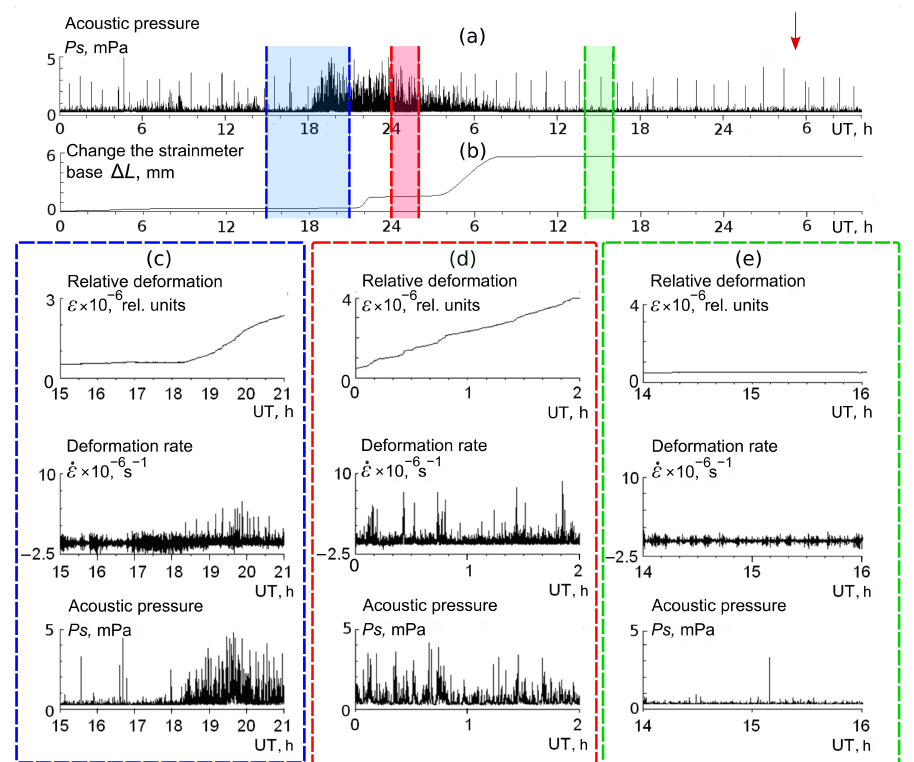
Figure 6. Record fragment of acoustic emission in different ranges and rock deformations from 00:00 on 6 October 2009, to 10:00 on 8 October 2009. ( a ) Variations of acoustic pressure P s , accumulated over 4 s in the frequency range 2.0–6.5 kHz, ( b ) change in the strainmeter base ∆ L . The red arrow shows the earthquake moment. At the bottom ( c – e ), enlarged fragments of the rock relative deformation ε , the deformation rate ˙ ε , and sound pressure P s , accumulated over 4 s in the frequency range of 2.0–6.5 kHz, are presented.